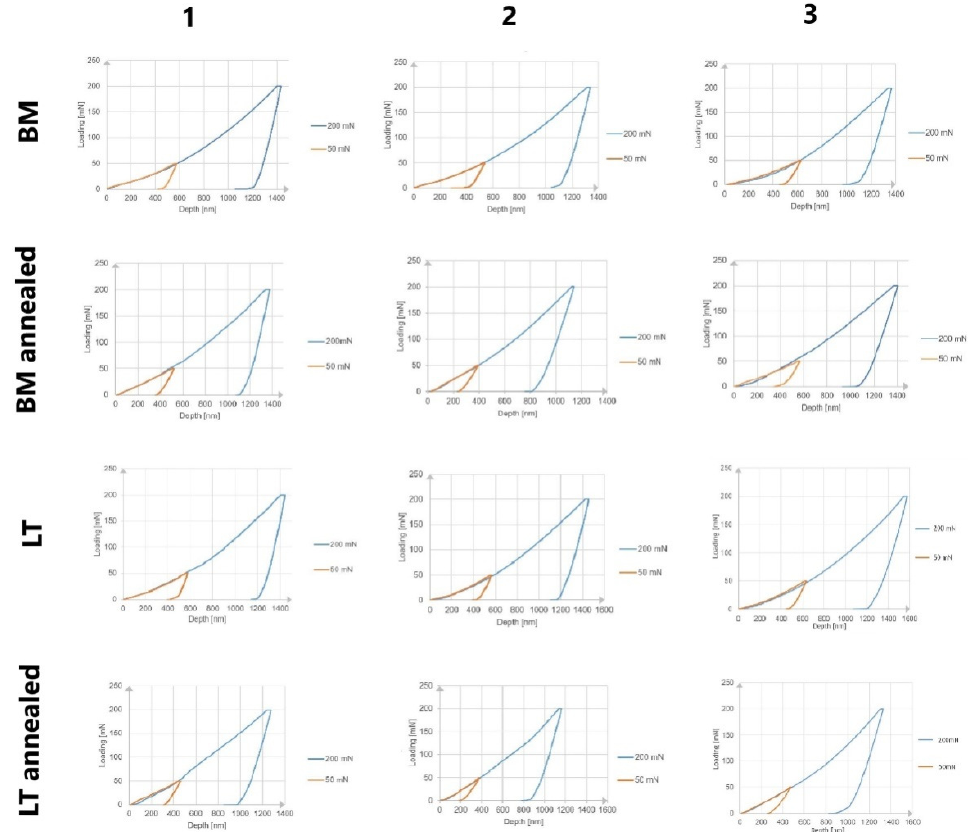
Figure 7. Indentation curves of samples BM and LT loaded with a maximum force of 50 and 200 mN. Table 9. Values adopted for the calculation of residual